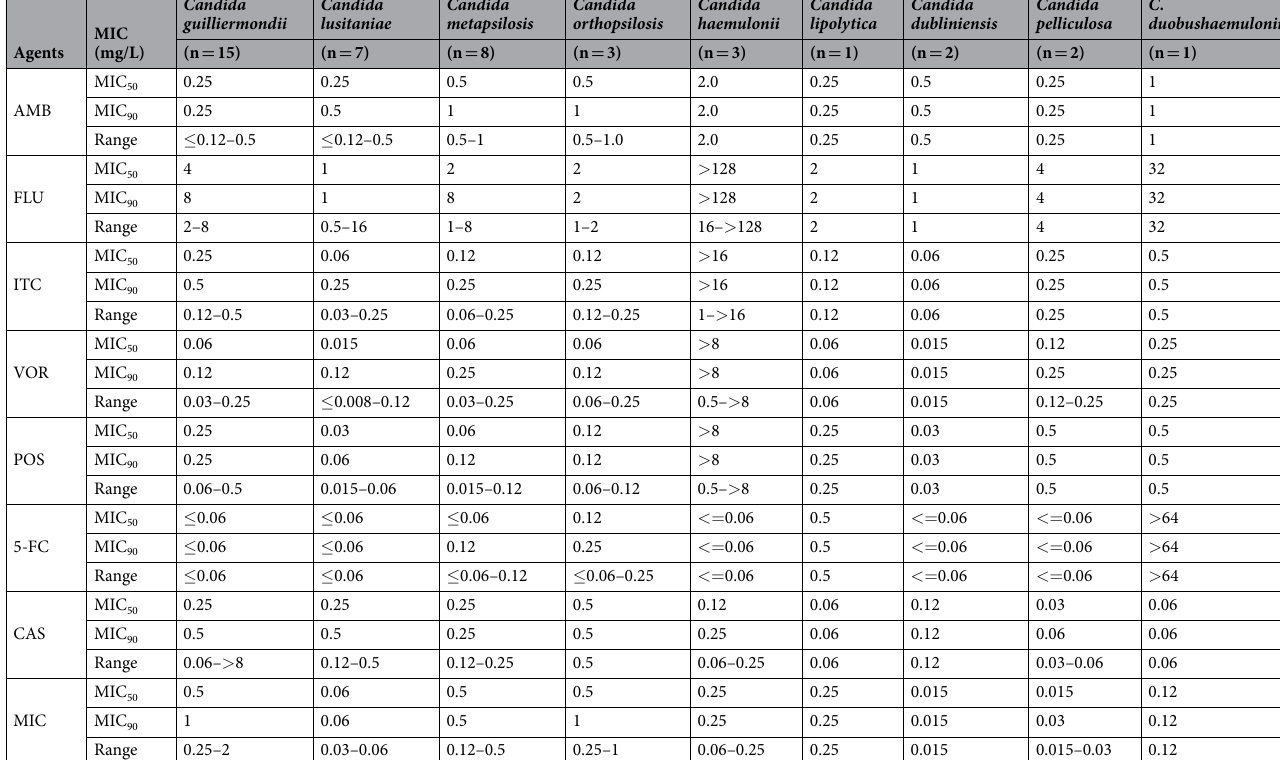
Table 4. Available susceptibility data for uncommon Candida isolates associated with candidemia in